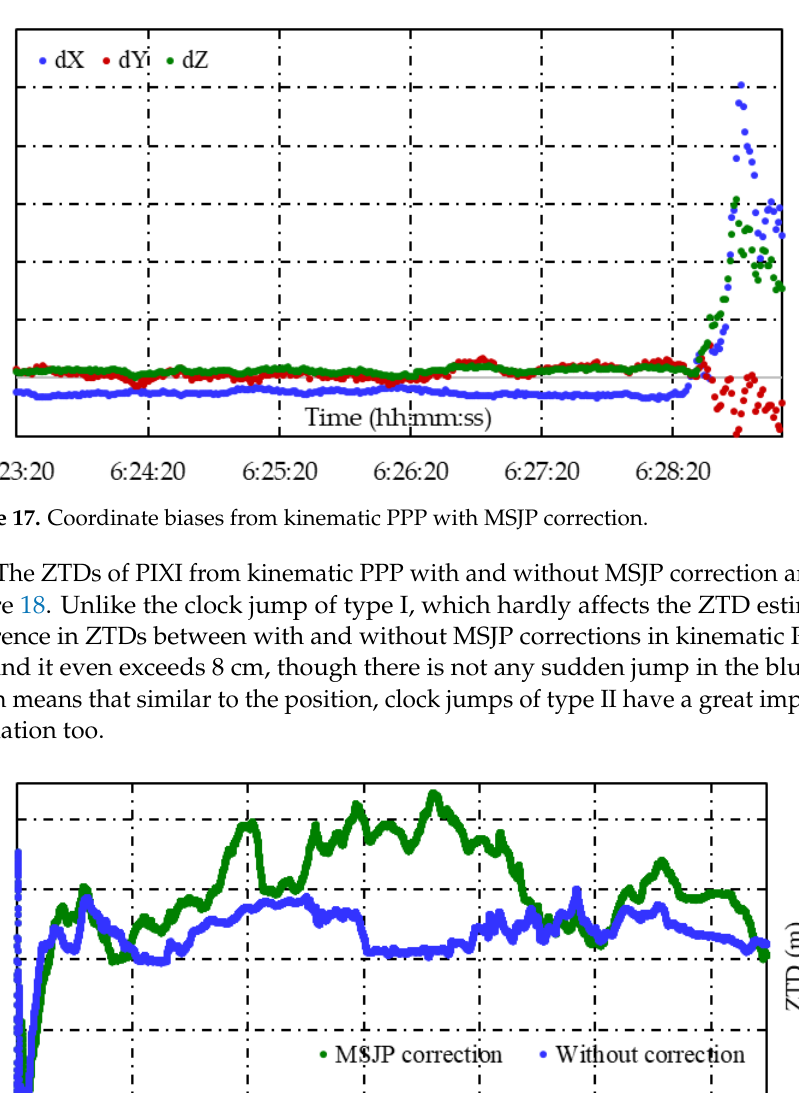
Figure 16. Coordinate biases from kinematic PPP without MSJP correction.